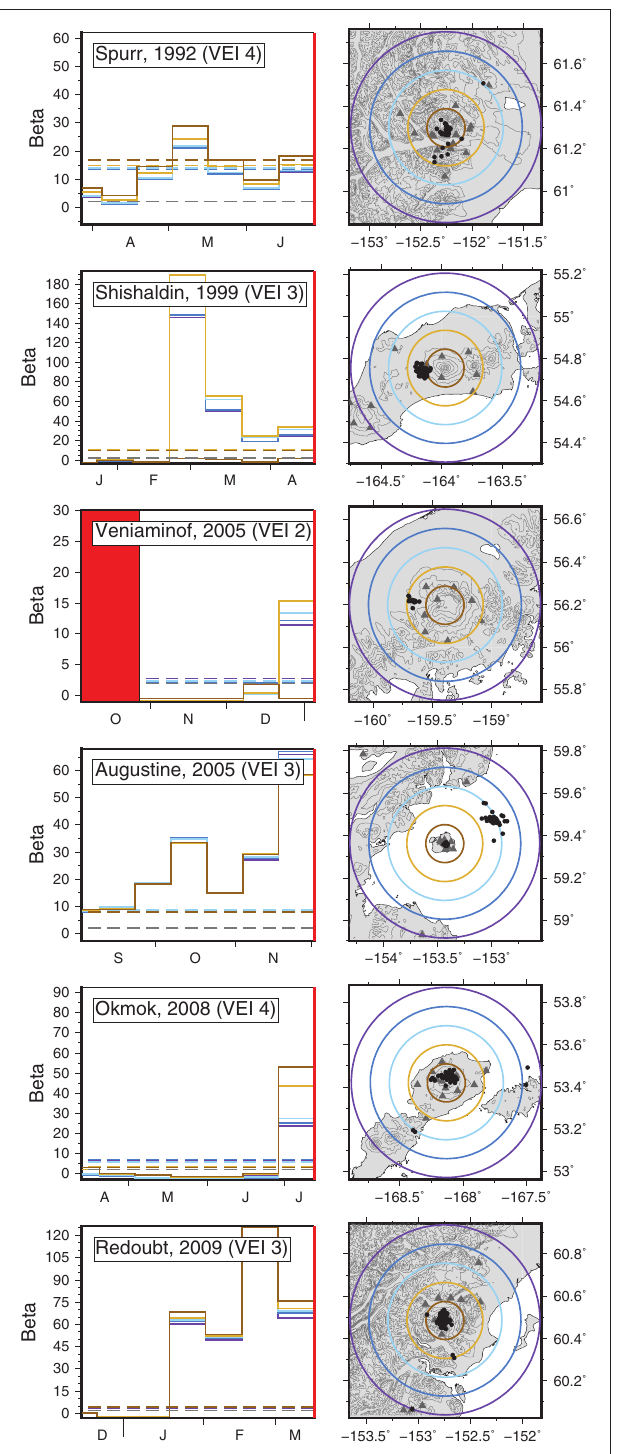
FIGURE 4 | Results of the β -statistic test for radial ( R ) values = 10, 20, 30, 40, and 50km (brown, yellow, light blue, dark blue, purple). T a = 14 days for all results shown. X-axes show the 3 months prior to the eruption. Y-axes are scaled by the maximum anomaly seen over the entire time period analyzed (see Figure 7 ). Maps show earthquakes within T a = 14 days of eruption. See Figure 2 and text for additional details.